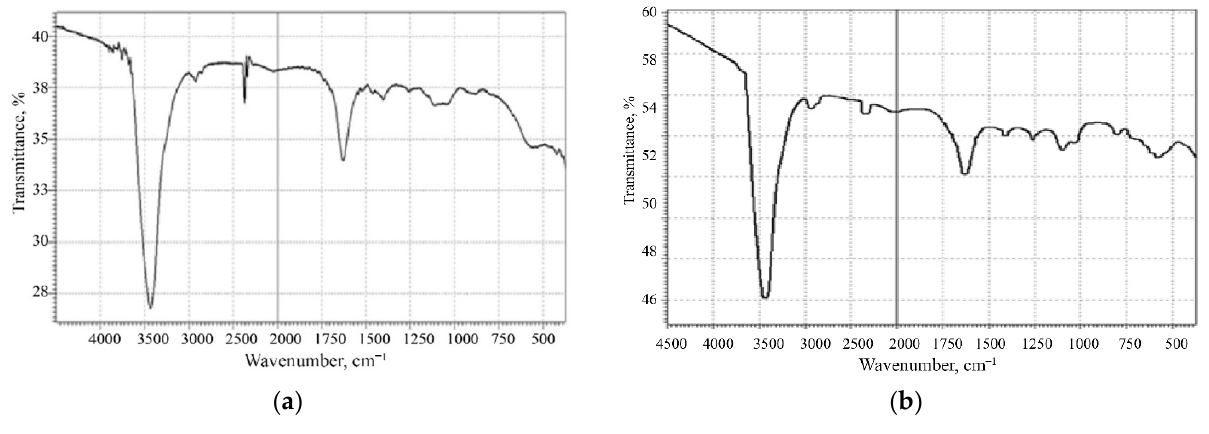
Figure 3. Size distribution of thermally reduced graphene oxide particles in the aqueous suspension. The qualitative composition of the surface functional groups in the process of thermal reduction did not change ( Figure 4). There was a marked decrease in the intensity of the peak at 3417 cm −1 and the band between 2800 cm −1 and 3100 cm −1 , compared to the original multilayer graphene oxide. The sp 2 -hybridization of C=C in the graphene structure (peak at 1627 cm −1 ), epoxy groups -C-O-C- (band between 1106 cm −1 and 1005 cm −1 ), and carboxylic groups -COOH- (band at 1384 cm −1 ) were also registered. The peak at 2300 cm −1 corresponded to the peak of absorbed CO 2 molecules.